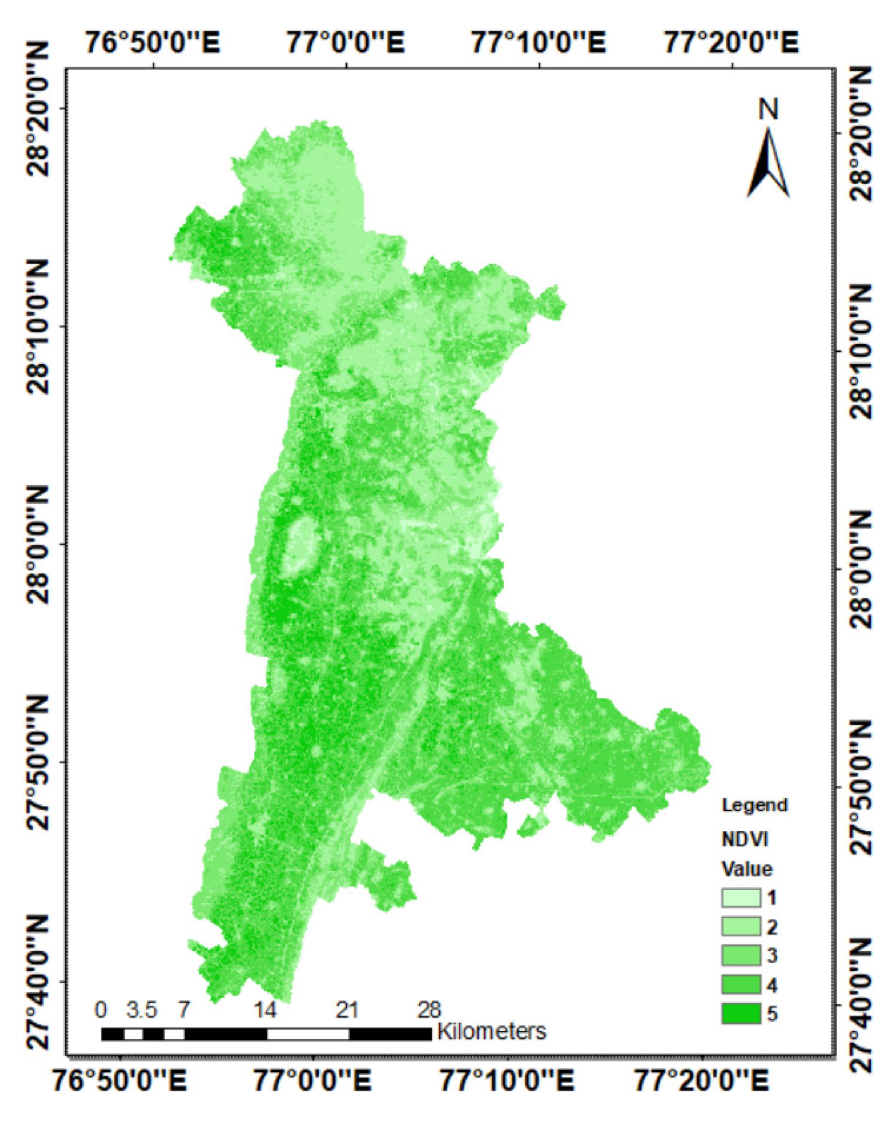
Fig. 11 Normalized difference vegetation index (NDVI) map of study